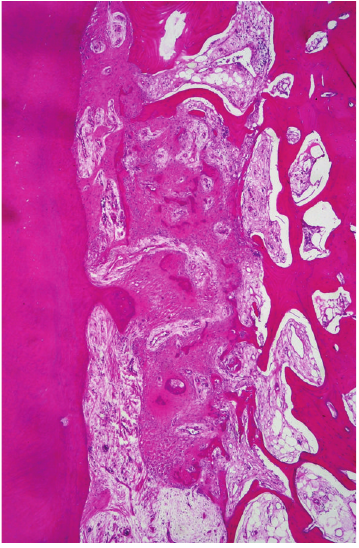
Figure 10: Osseous dysplasia. Between root surface (left) and alveolar socket (right) the periodontal ligament shows the presence of irregular bony particles.